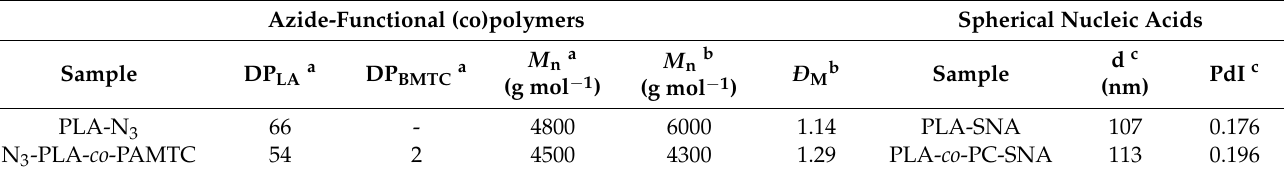
Figure 3. N 3 -PLA- co -PAMTC copolymer characterization via: ( a ) 1 H NMR (600 MHz) spectroscopy in CDCl 3 ; ( b ) GPC in tetrahydrofuran vs. polystyrene narrow-molar-mass standards. Table 1. Characteristics of the azide-functional (co)polymers and the corresponding spherical nucleic